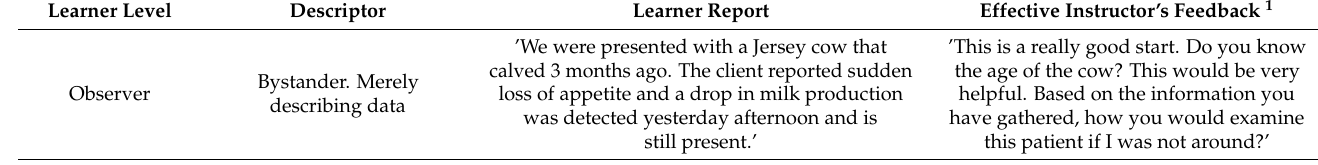
Table 2. Example clinical encounter: Apparently anestrus mature dairy